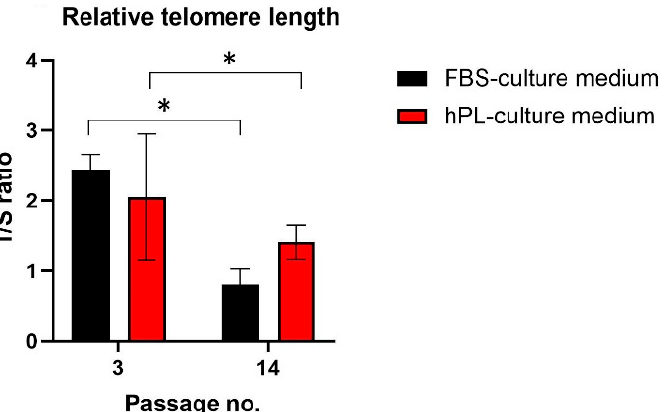
Figure 9. Average relative telomere length measured between 3rd and 14th passages using qPCR. Both groups of hNDP-SCs experienced the shortening of relative telomere length in the 14th passage (* p < 0.05), but it was more noticeable in the case of hNDP-SCs cultivated in the medium with 2% FBS. The data are presented as the mean ± SD. The Shapiro–Wilk test or Kolmogorov–Smirnov test were used for normal distribution evaluations. The statistical analyses were calculated using the paired t -test.